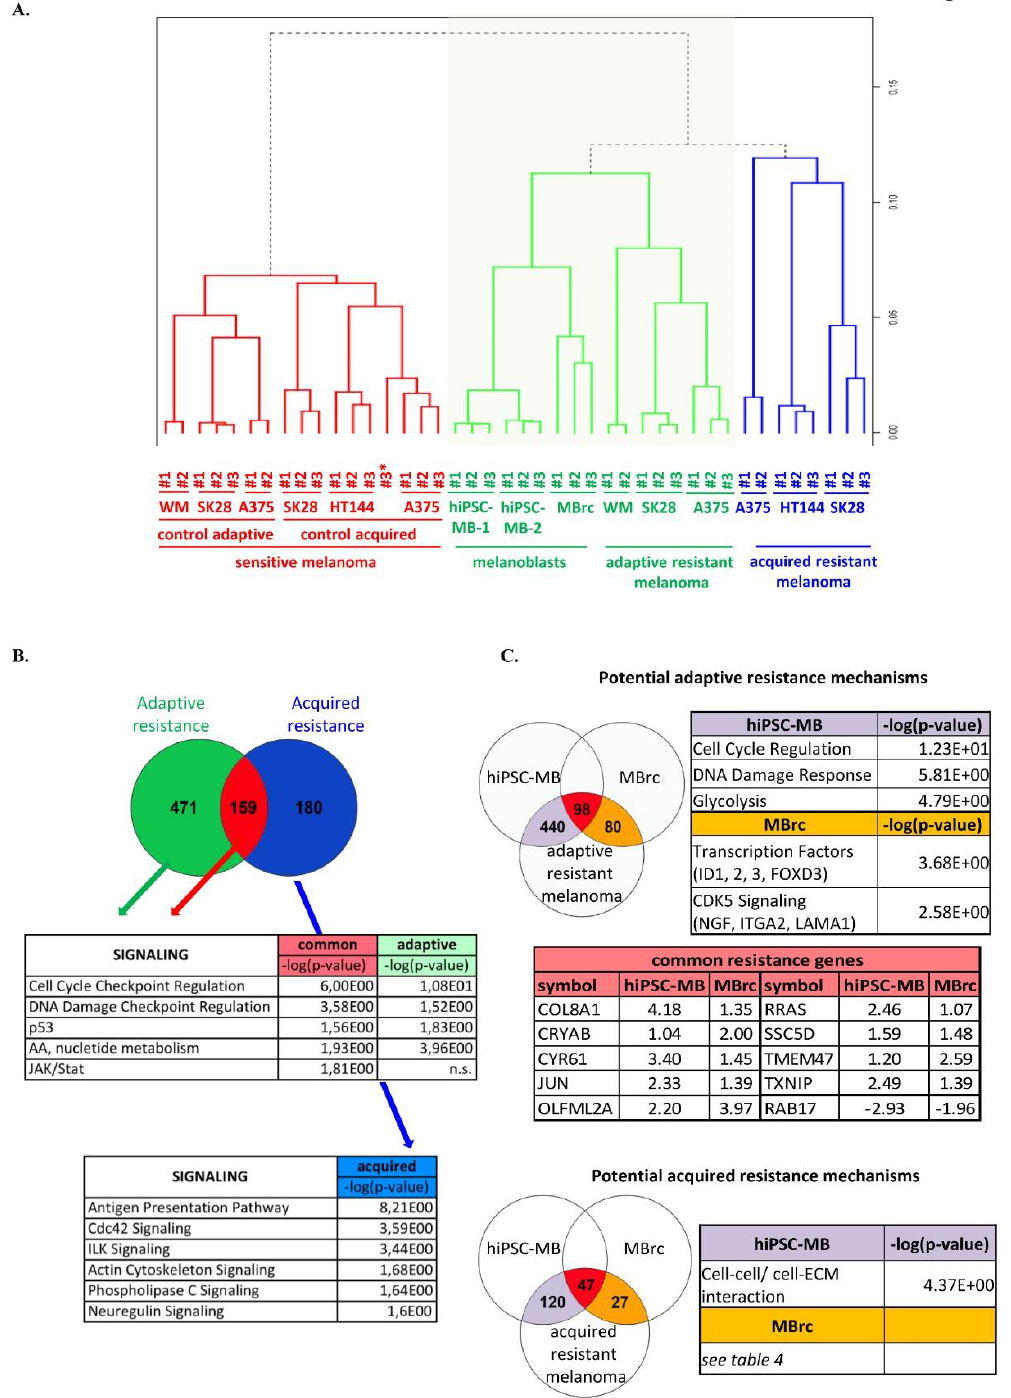
Figure 2. The transcriptome of melanoblasts is closer to that of adaptive resistant melanoma than to that of acquired resistant melanoma. ( A ) Dendrogram representing hierarchical clustering of the transcriptome of the two melanoblast populations (green label) and of adaptive (green label), acquired resistant (blue label), and sensitive (red label) metastatic melanoma cell lines. Note: A375#3* belongs to the control adaptive sensitive melanoma sample. The function hcluster was used, in which the parameter correlation evokes the computation of Pearson-type distances. “WM” melanoma cell line stands for “WM266-4”. ( B ) Venn diagram representing the regulated genes in either adaptive resistant melanoma samples and melanoblasts samples (green circle) or acquired resistant melanoma samples and melanoblasts (blue circle), compared to the respective sensitive melanoma samples. Gene set enrichment analysis was performed for the two gene lists with Ingenuity software (IPA). The results